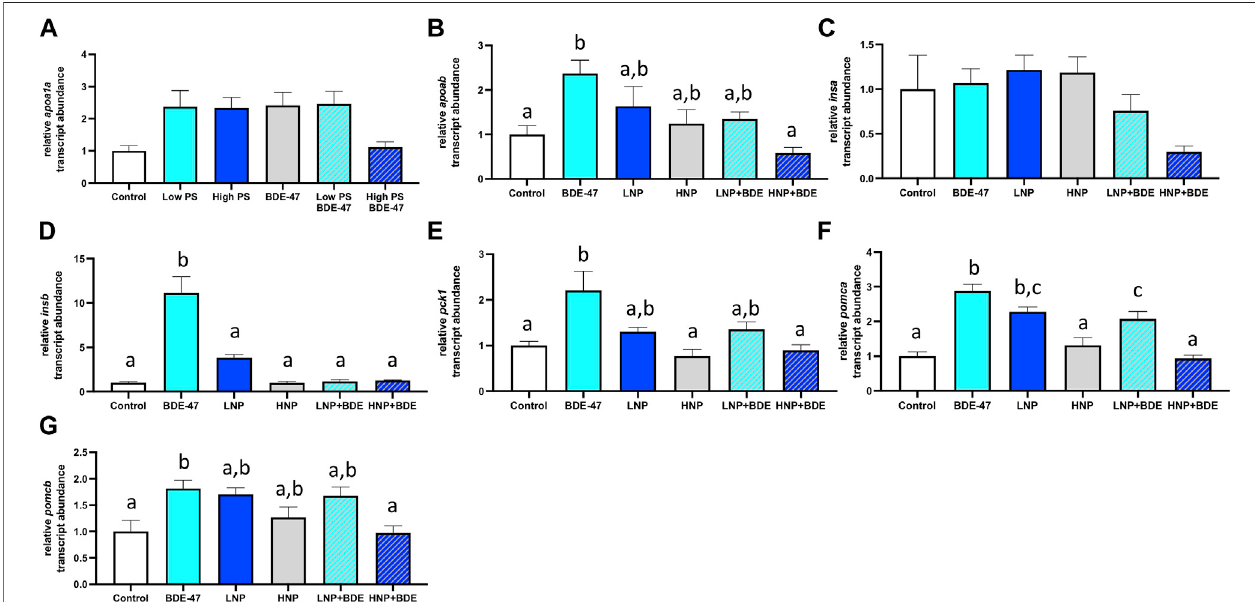
FIGURE 9 | Relative abundance of mRNA transcripts with characterized roles in energy metabolism in whole 7 dpf larvae. Treatment groups consist of exposures to vehicle control, 2.5 ppm PS, 25 ppm PS, 10 ppt BDE-47 or their combinations. Apolipoprotein transcripts apoa1a (A) and apoab (B) , insulin paralogue transcripts insa (C) and insb (D) , the gluconeogenic marker pck1 (E) and pomc paralogues pomca (F) and pomcb (G) . Average mRNA transcript abundance +S.E.M. of n = 4 pooled replicates per treatment group containing n = 10 larvae per replicate are shown. Relative transcript abundance was normalized to control group to re fl ect fold-change. All data was analyzed using one-way ANOVAs with a signi fi cance cut-off of p < 0.05. Where omnibus tests revealed a signi fi cant treatment effect, Tukey ’ s post-hoc test ( p < 0.05) was used to discern signi fi cant differences between treatment groups, which are indicated by different letters.